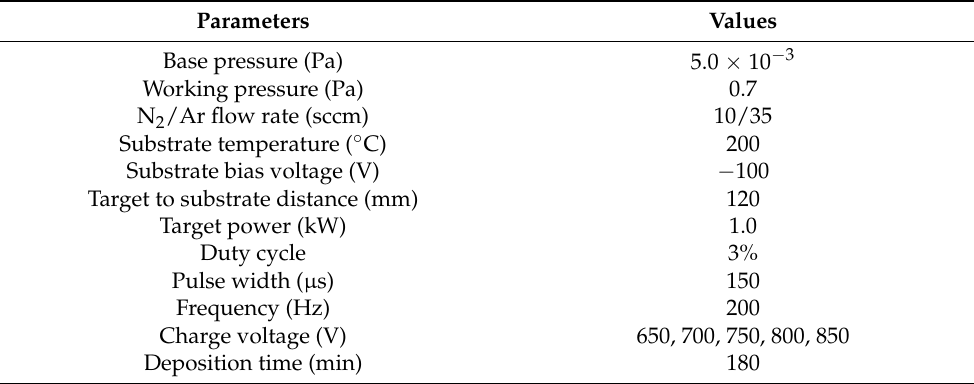
Table 1. Deposition parameters of Mo–Cu–V–N